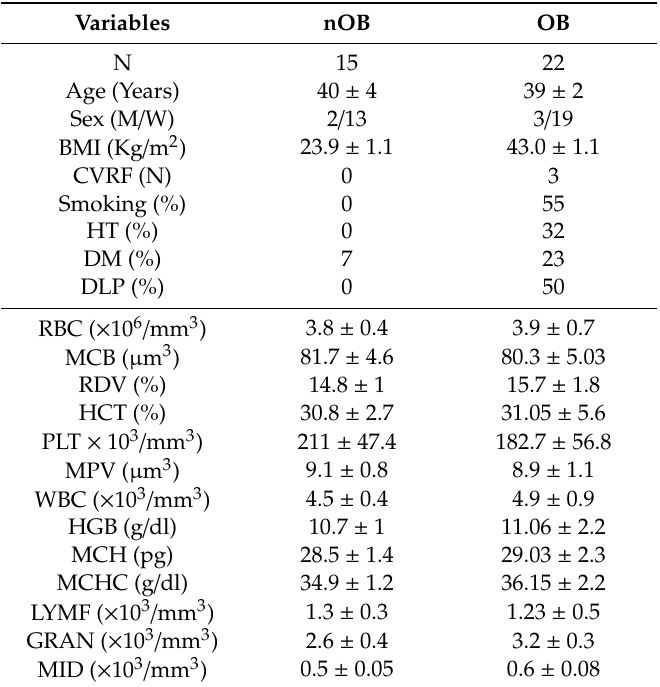
Table 1. Clinical characteristics of the study patients.